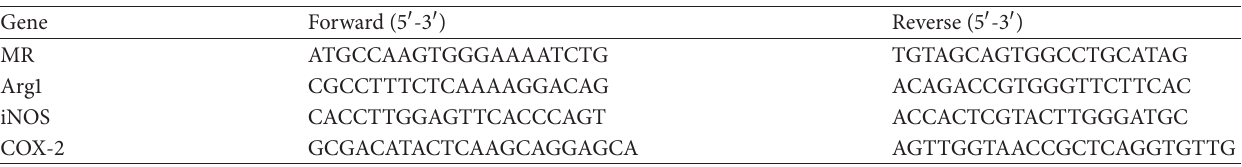
Table 1: Primer sequences for real-time